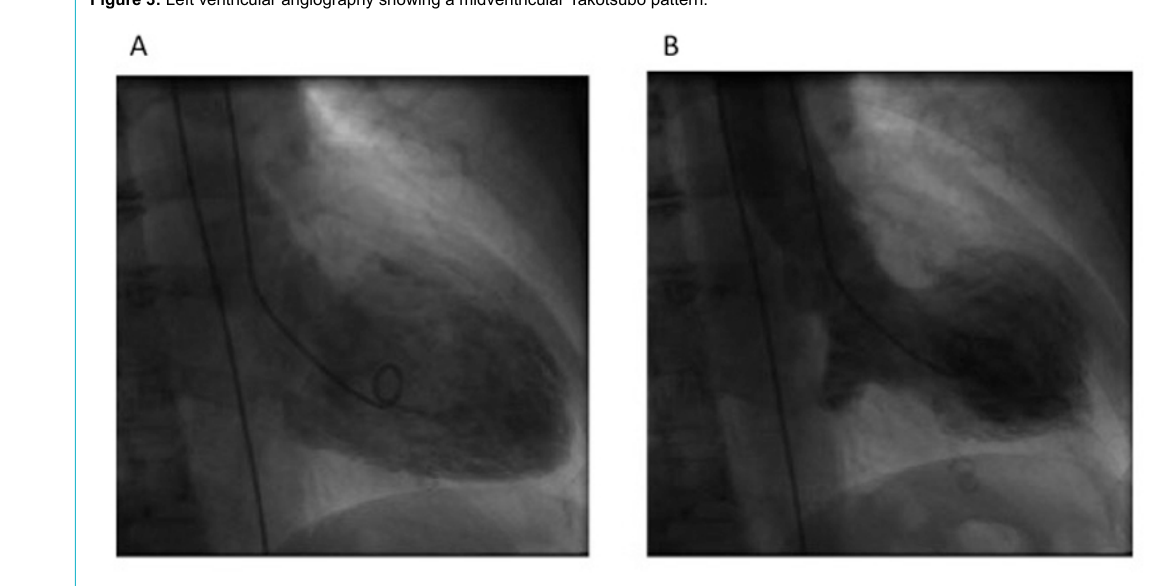
Figure 3: Left ventricular angiography showing a midventricular Takotsubo